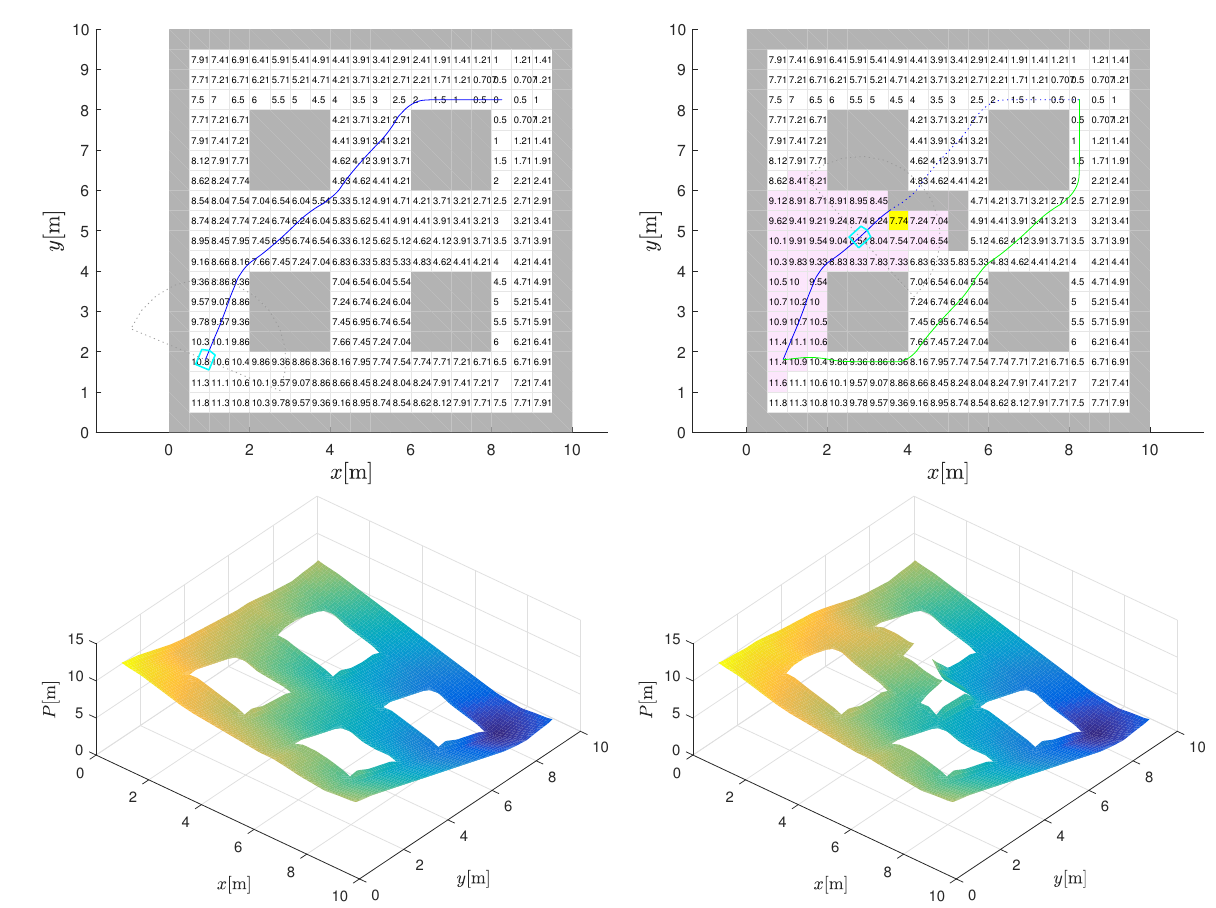
Figure 4. Augmented environment with new discoveries. Static map of environment with planned path in blue line towards goal ( top-left ). Change of environment with new L-shaped obstacle where robot (shown by the sky blue line and its sensor range by the gray dots) is blocked at stuck cell (highlighted by yellow) if continuing based on static CtG map. Replanned CtG values for new environment with highlighted light purple cells where CtG values have changed and new gradient- descent path in green ( top-right ). Interpolated potential (CtG, darker color denote lower values) surface before ( bottom-left ) and after the environment change ( bottom-right